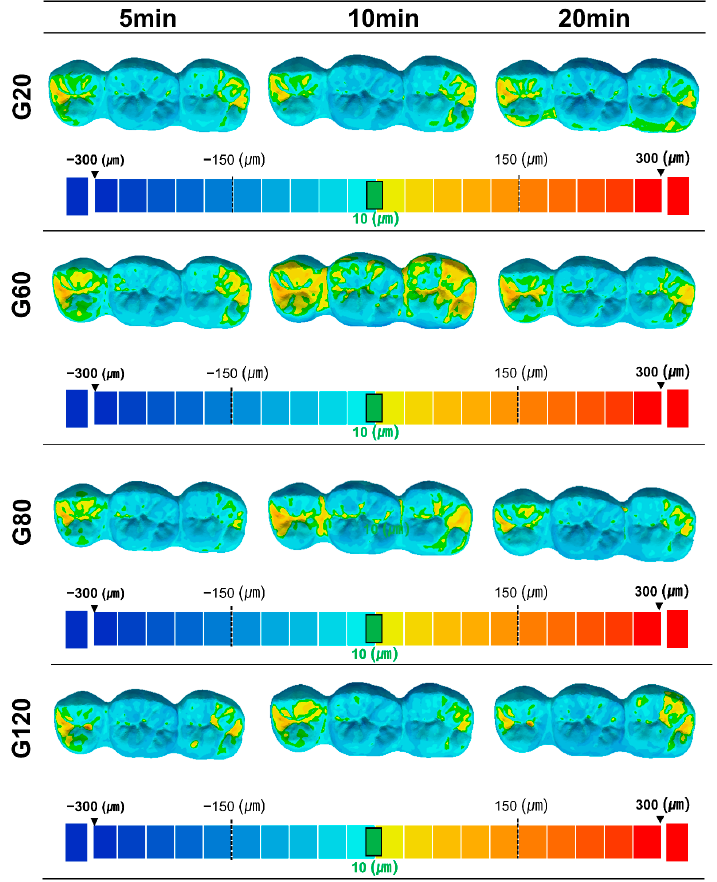
Figure 5. Three ‐ dimensional deviation color map. The display range of positive (red color) and neg ‐ ative (blue color) deviation from 300 to − 300 μ m, displayed in color to visualize the accuracy. In − 300 µ m, displayed in color to visualize the accuracy. In particular, the area with a deviation within 10 μ m is displayed in green. negative (blue color) deviation from 300 to particular, the area with a deviation within 10 µ m is displayed in